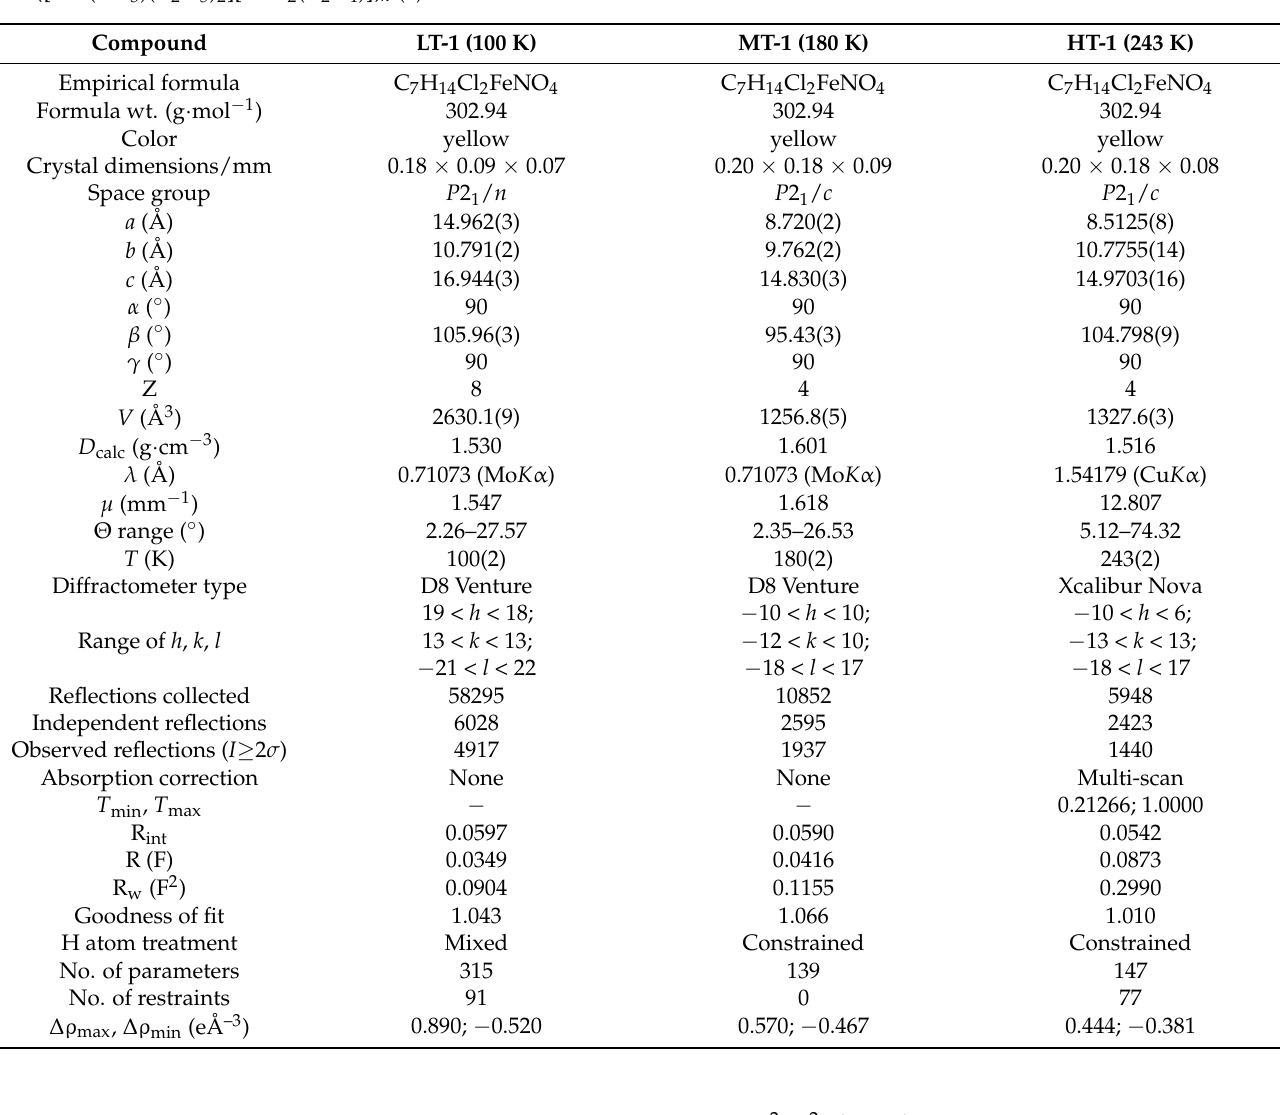
Table 1. Crystallographic data and structure refinement details for variable-temperature X-ray diffraction of